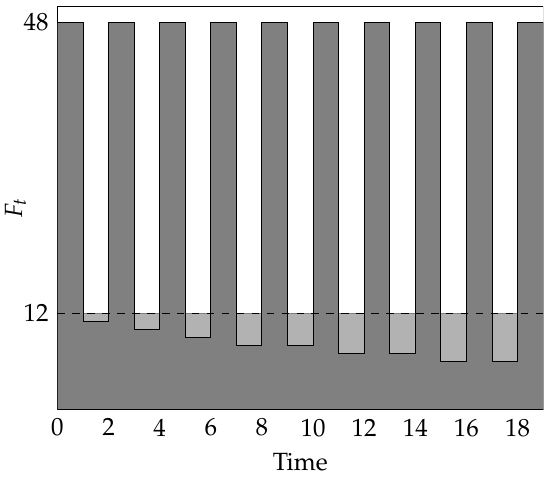
Figure 2. An example of the corresponding minCC instance to the three-partition instance with multiset { 1,2,3,4,4,5,5,6,6 } . The dashed line gives the upper bound on the flow, which is given by the dark grey area. The light grey area is the amount that can be discharged during the even time intervals, corresponding to 1,2,3, . . .